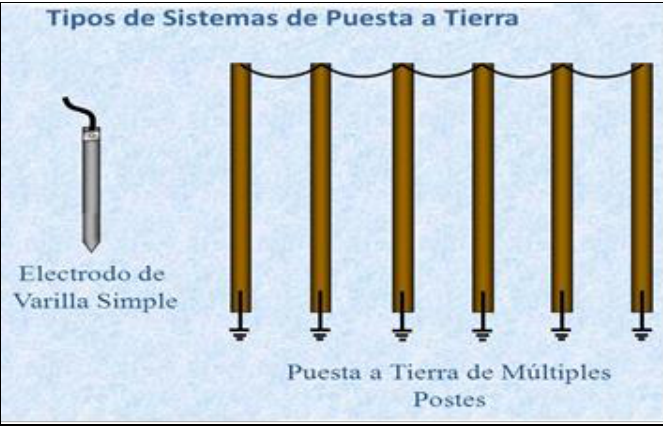
Figura 14: Tipos de sistemas de puesta a tierra. Fuente: Los Autores,